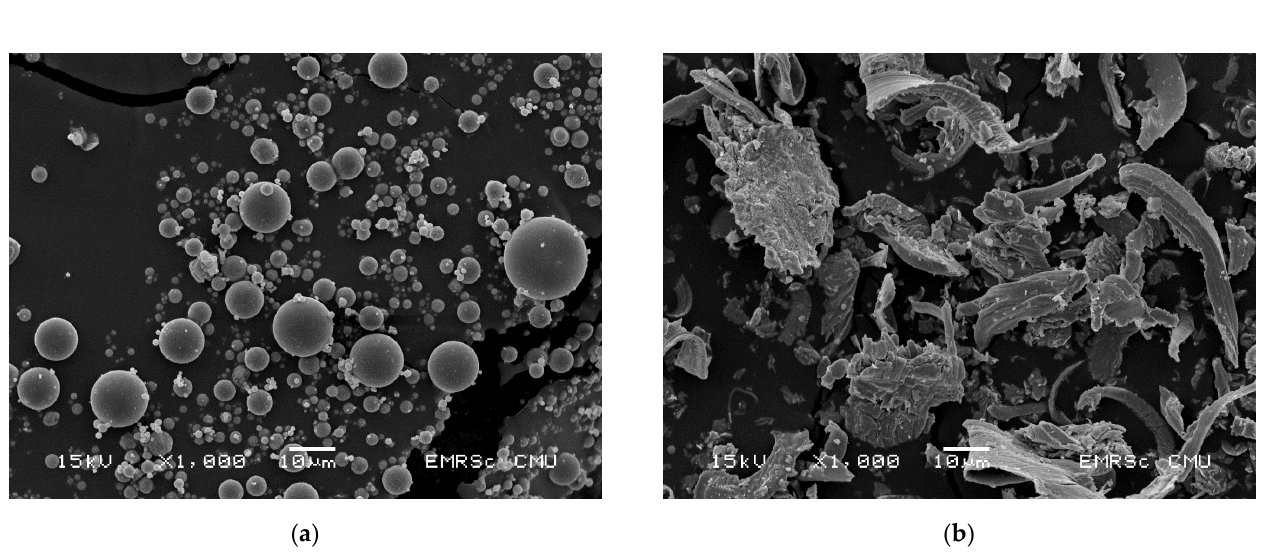
Figure 1. Microstructure of materials by SEM: ( a ) FA at 1000× magnification, ( b ) Waste iron powder at 1000× magnification.